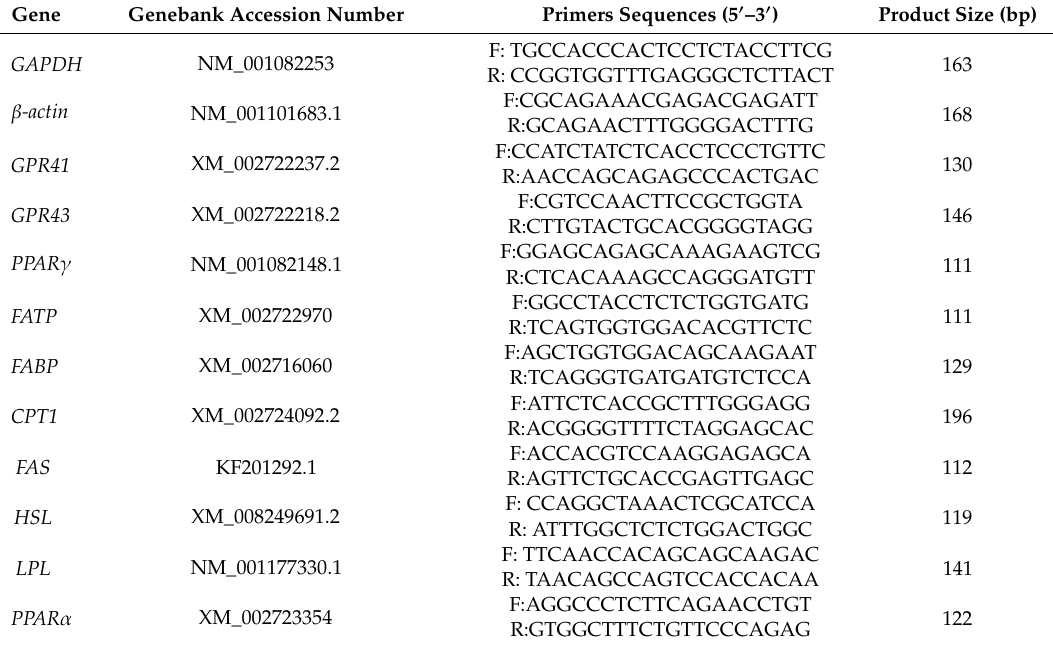
Table 1. Rabbit primers information for gene